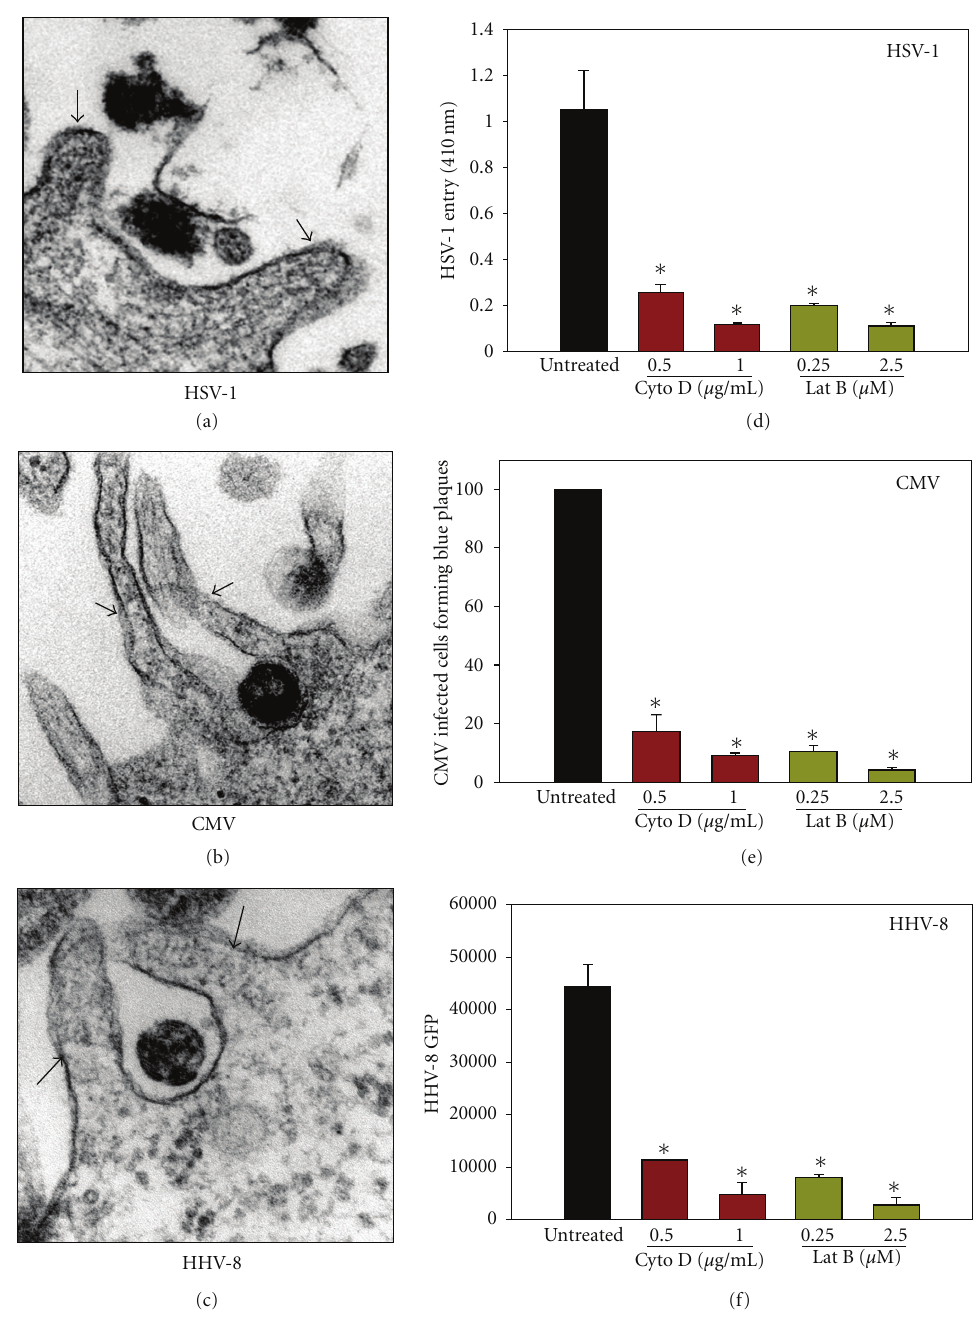
Figure 2: Herpesviruses can be internalized by membrane protrusions and blocking of protrusion formation blocks herpesvirus entry. (a)– (c) High-resolution transmission electron micrographs (TEMs) of human ocular cells infected with herpesviruses are shown. Arrowheads in the panels indicate the association of viruses to cellular projections. (d)–(f) F-actin-dependent uptake of herpesviruses into ocular cells. E ff ects of actin depolymerizers (cytochalasin D; Cyto D and latrunculin b; Lat B) on virus entry into ocular cells (CF (d) for HSV-1, RPE cells for CMV (e), and HCjE for HHV-8 (f)) were examined. Cells were treated with Cyto D or Lat B at concentrations indicated for 90 min before exposure to the virus indicated. Asterisks indicate significant di ff erences from controls ( P < 0 . 05, t -test n = 14, error bars represent